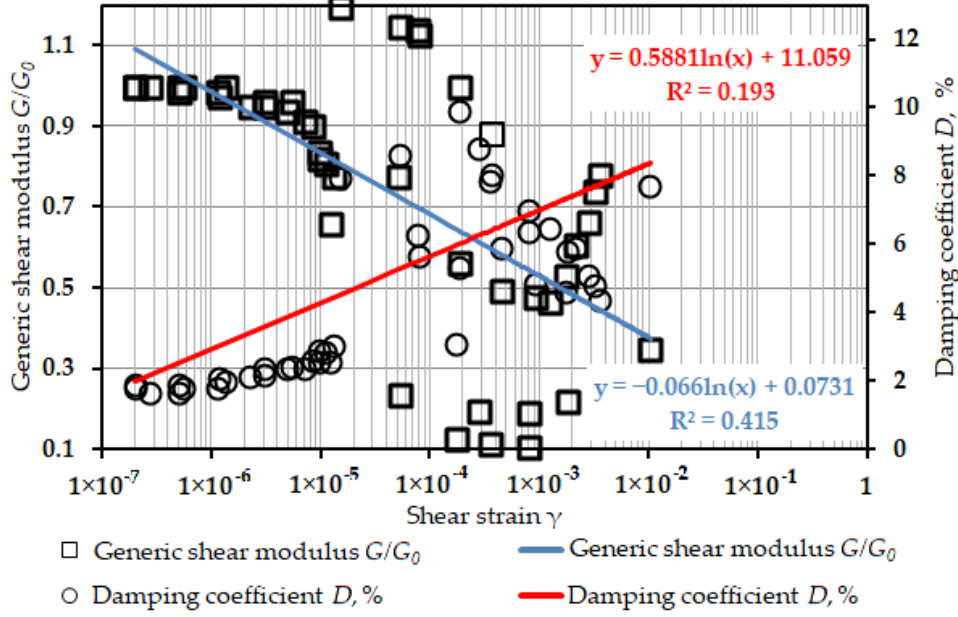
Figure 3. Summary graph of dependencies of generic shear modulus G/G 0 (unit fractions) and damping coefficient D (%) on the amplitude of shear strains γ (unit fractions) for cement-stabilized soils (according to the results of six